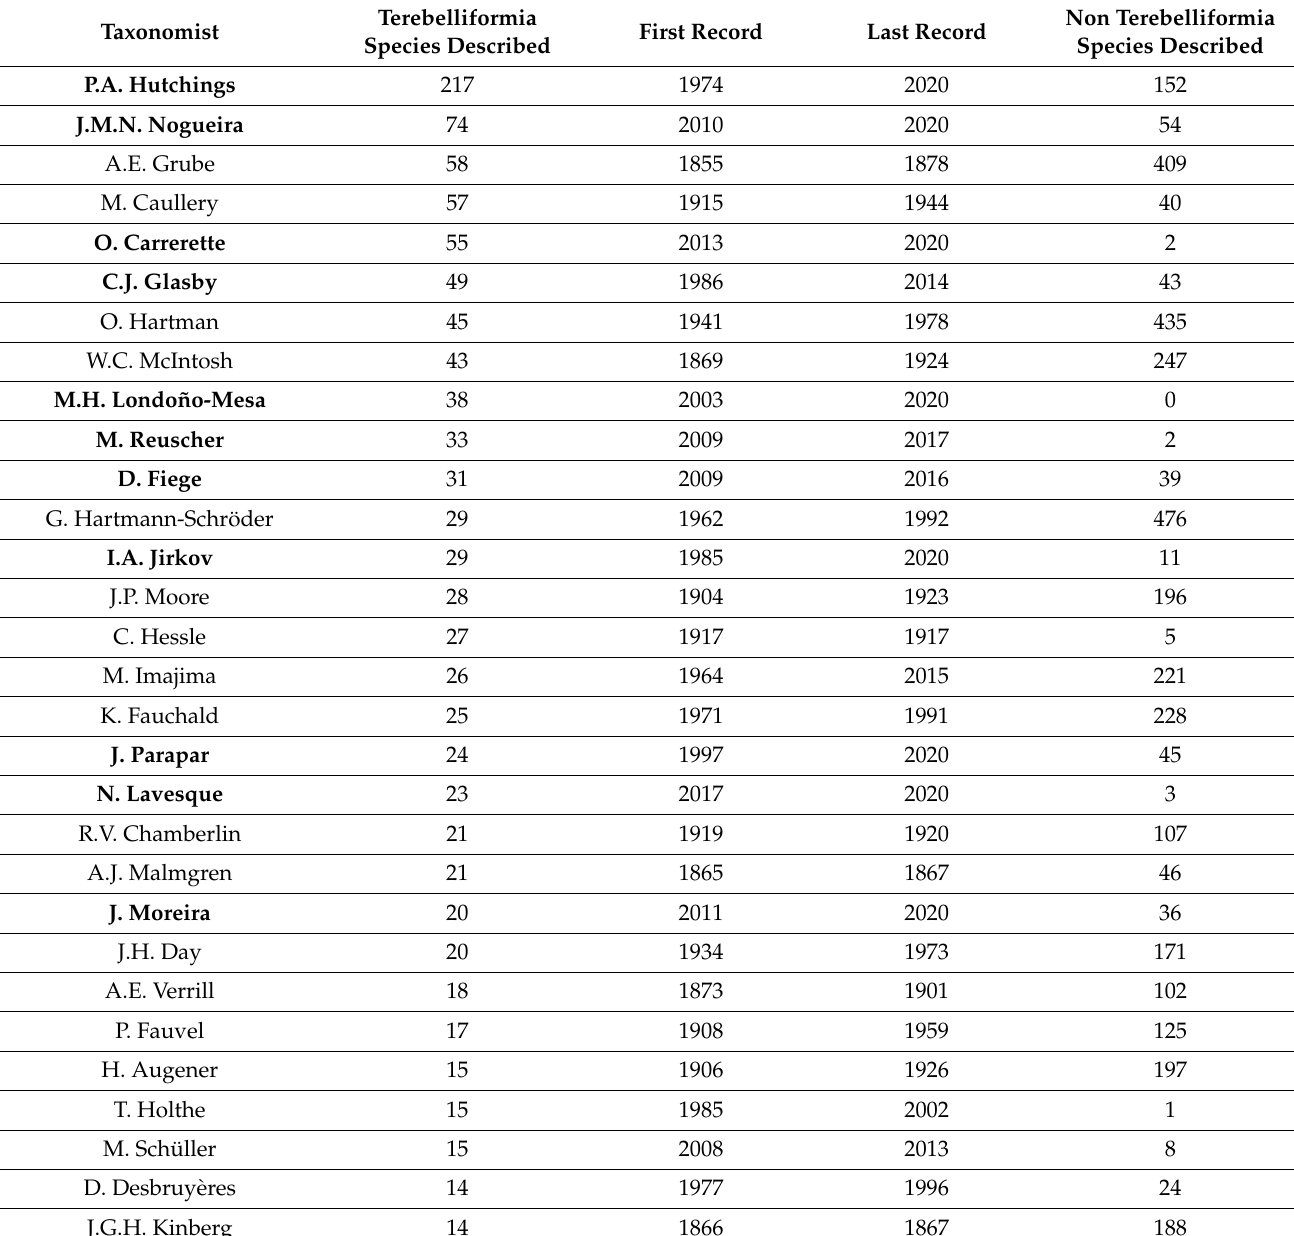
Table 1. The top 30 most prolific authors along with their numbers of Terebelliformia species described, first and last discoveries, and other polychaetes species described. Names in bold refer to active